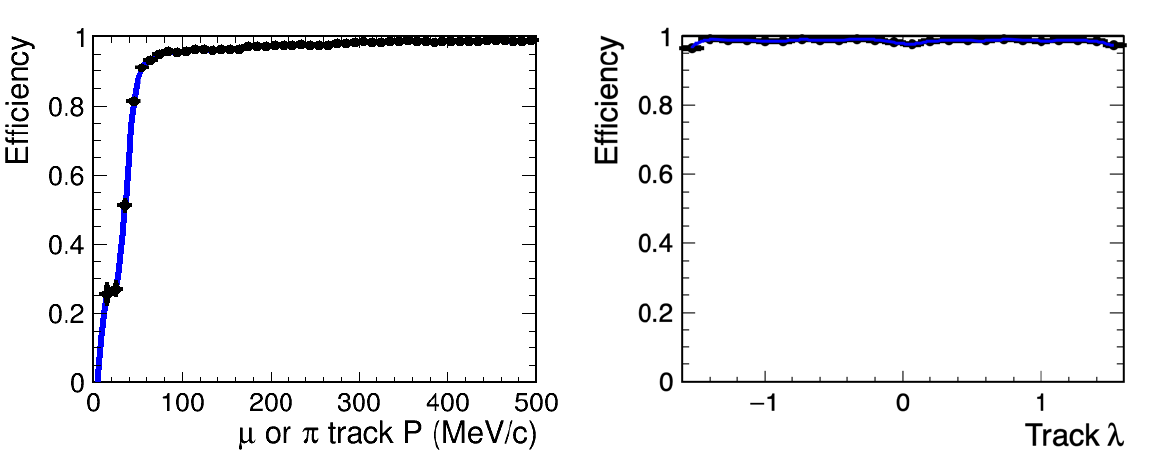
Figure 60. ( Left ) The efficiency to find tracks in the HPgTPC as a function of momentum, p , for tracks in a sample of GENIE events simulating 2GeV ν µ interactions in the gas, using GArSoft. ( Right ) The efficiency to find tracks as a function of λ , the angle with respect to the center plane (in radians), for tracks with p > 200MeV/ c .